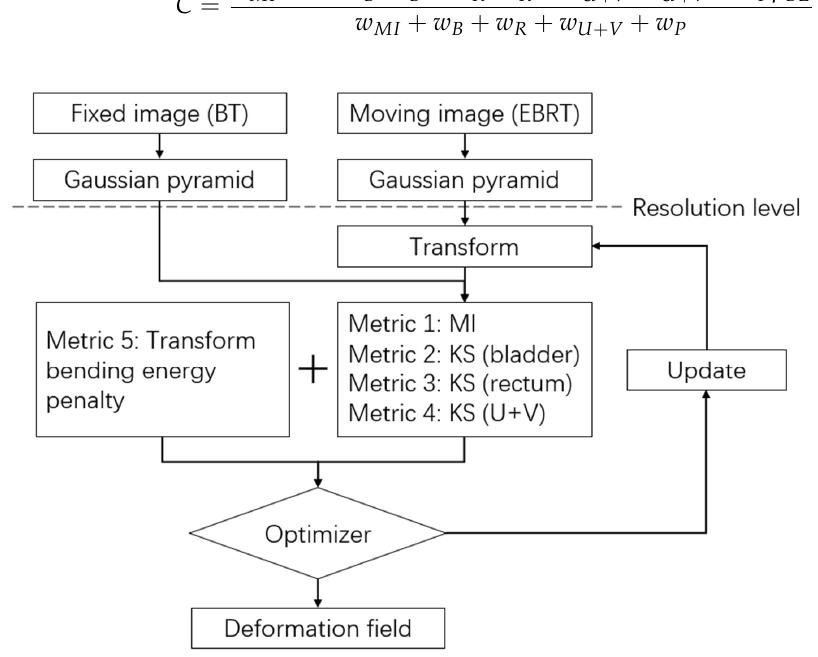
Figure 2. Flowchart of the multi ‐ metric DIR process.